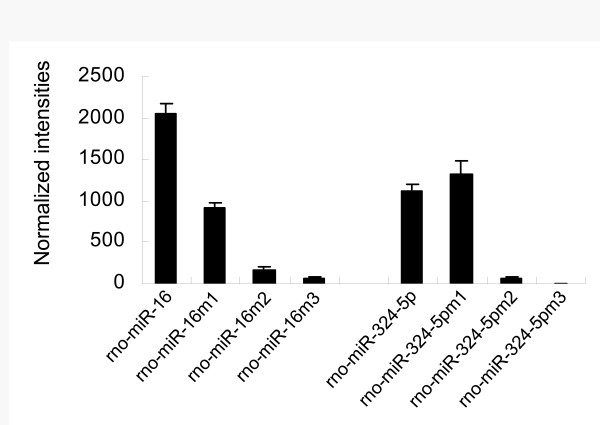
Specificity of miRNA microarray hybridization. The control oligos in the 3 DNA array900 microRNA direct kit were ligated with Cy5 capture sequence and hybridized onto one block. The mismatched probes had one (m1), two (m2) or three (m3) mismatched nucleotides with the corresponding control oligos. The signals from the slide were processed with the method described in Materials and Methods. Data shown were means ± S.E. from 3 hybridizations.